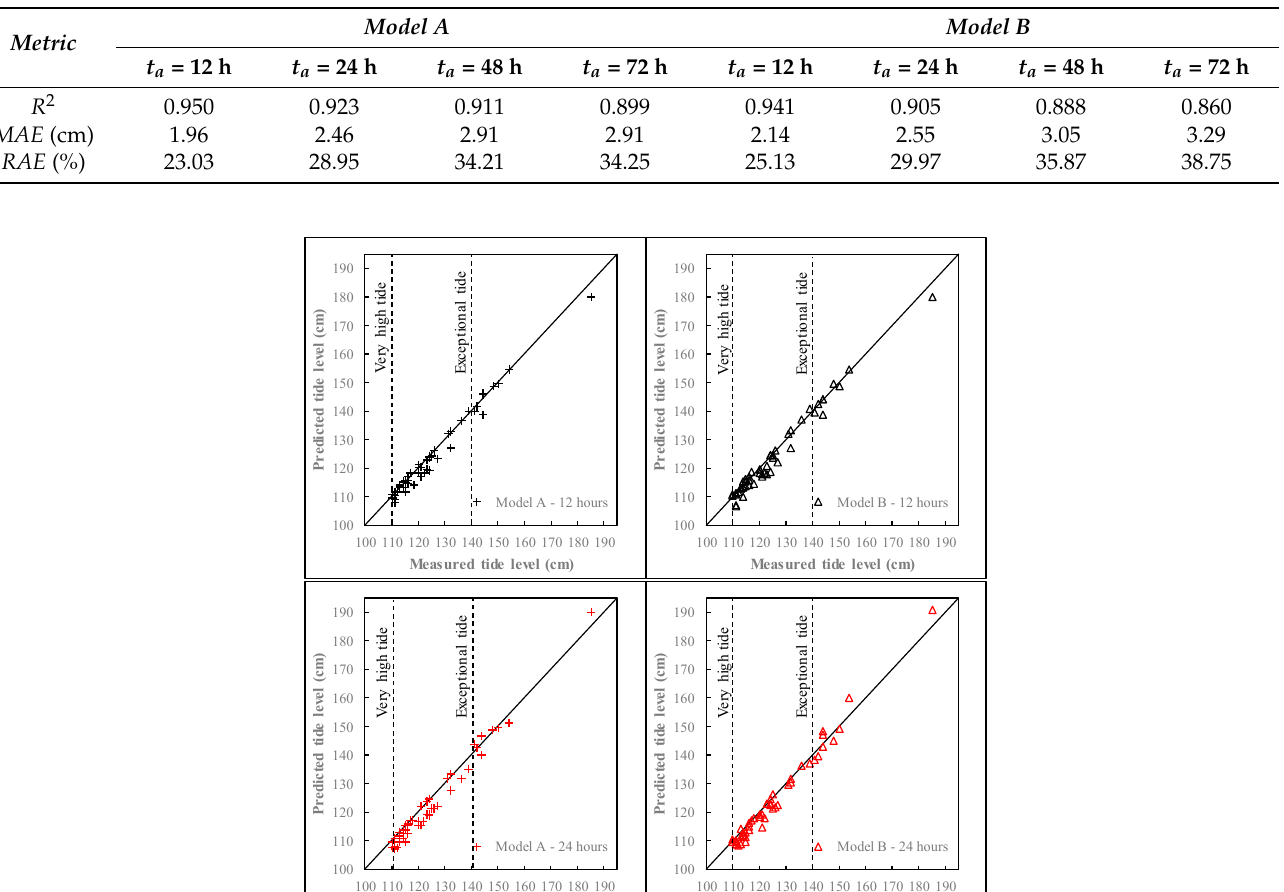
Table 1. Forecasting performance.